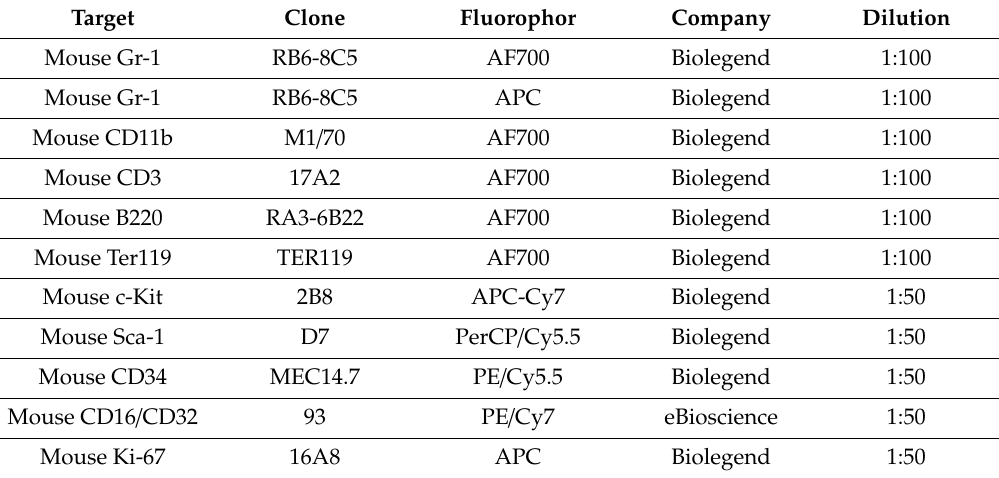
Table 2. Antibodies used for flow